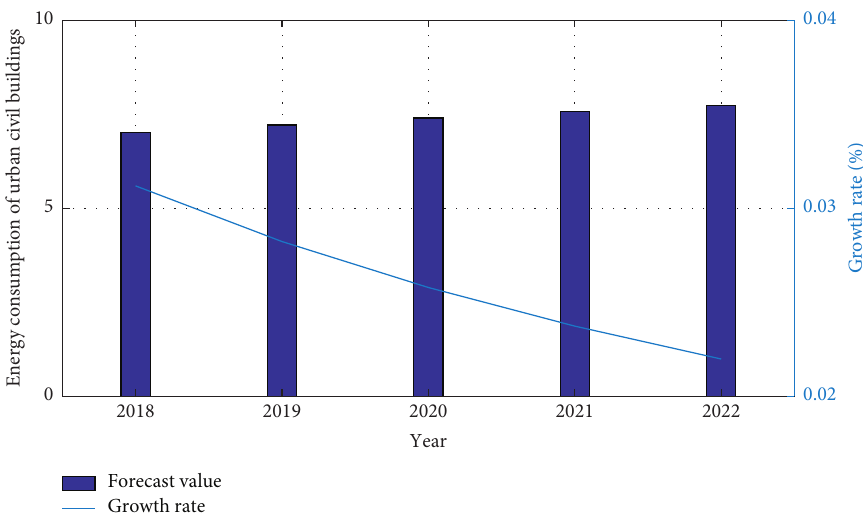
Figure 15: Energy consumption of urban civil buildings and growth rate over the next 5 years.